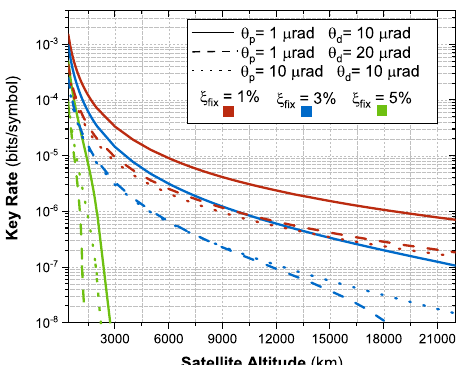
Fig. 11 Impact of the beam quality on key rate. Comparison of secret key rate for different values of pointing error, θ p , and divergence angle, θ d at the three excess noise values.